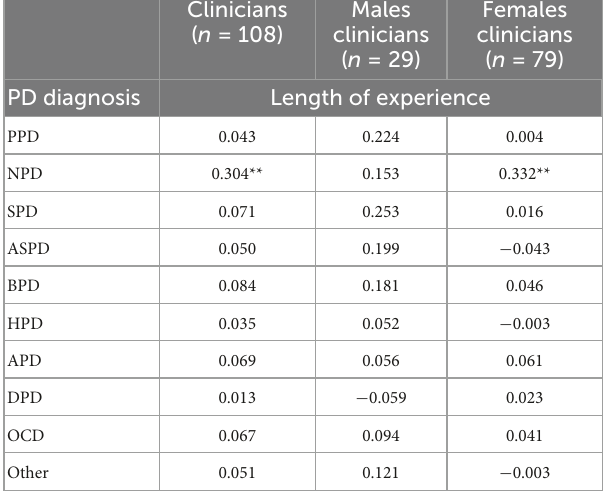
TABLE 8 Spearman’s rho correlations in clinicians between length of experience and diagnosis in vulnerable narcissism condition.